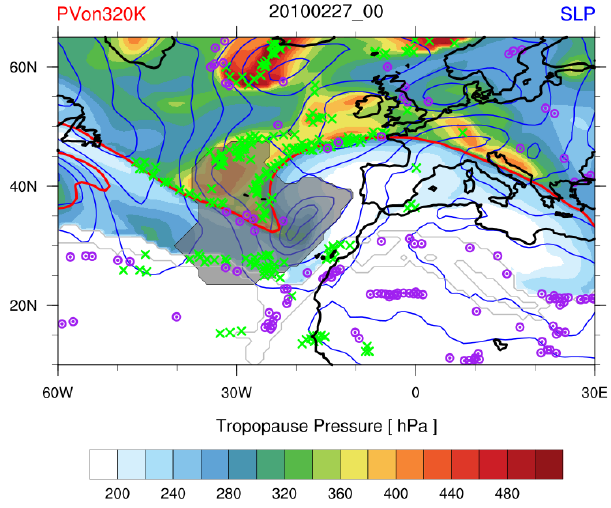
Figure 4. As Fig. 2 but at 00:00UTC 27 February